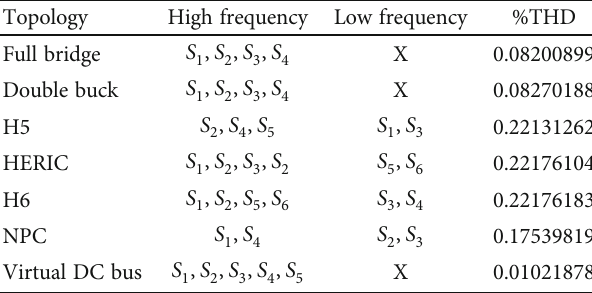
Table 9: Inverter THD comparison.